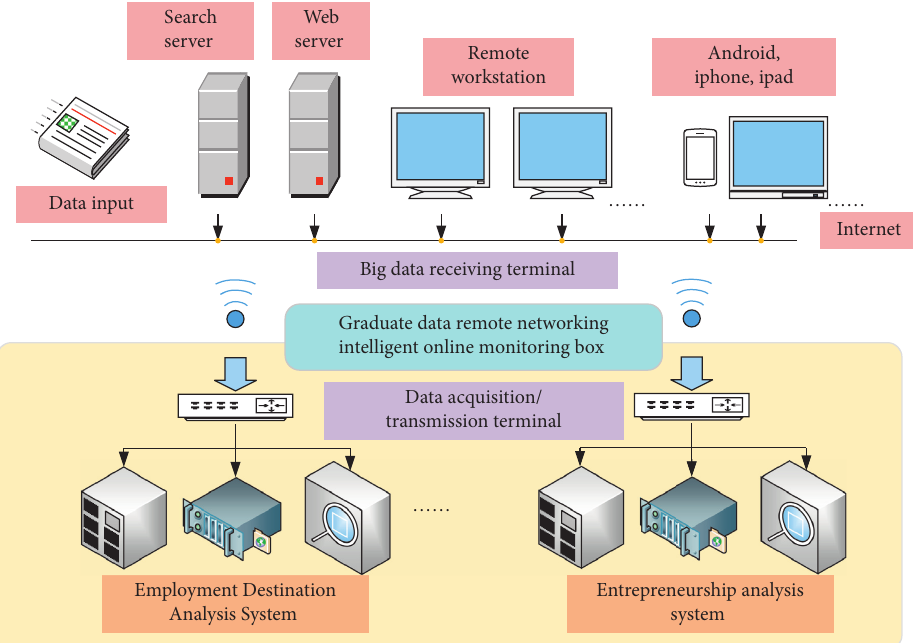
Figure 2: The big data system’s analysis process of graduate employment data.